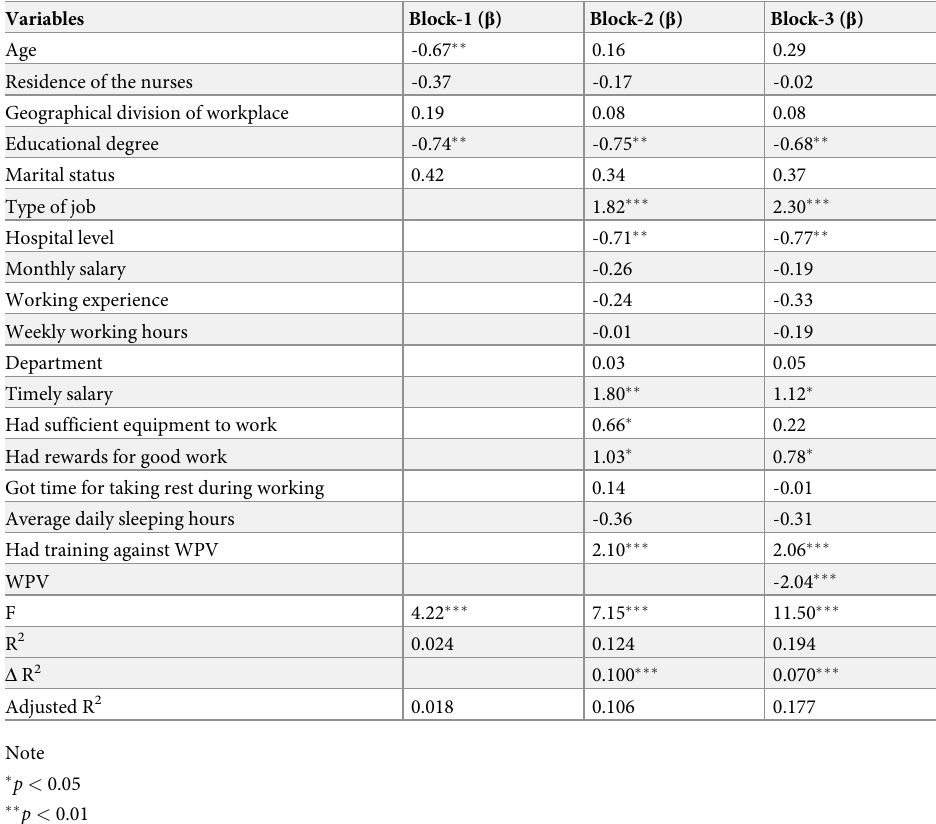
Table 5. Predictive models of turnover intention (n =